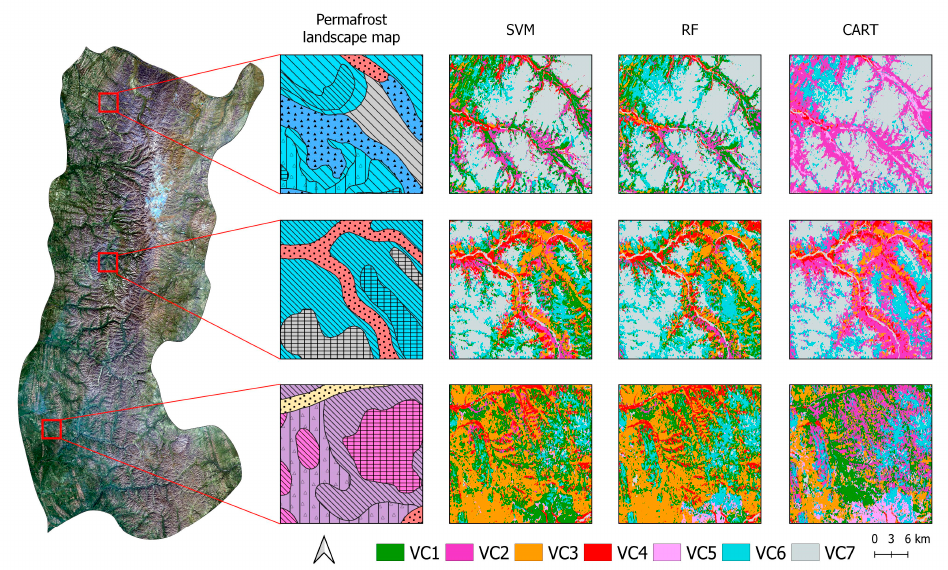
Figure 3. Vegetation classification results by SVM, RF, and CART classifiers for the Orulgan